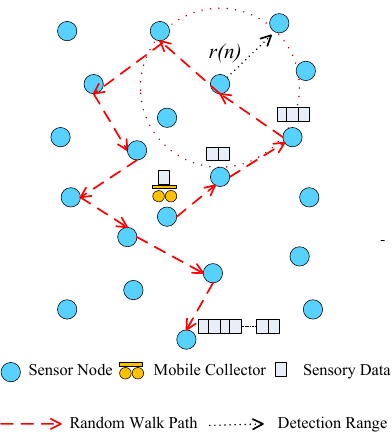
Figure 1. An example of data collection with a mobile collector in a